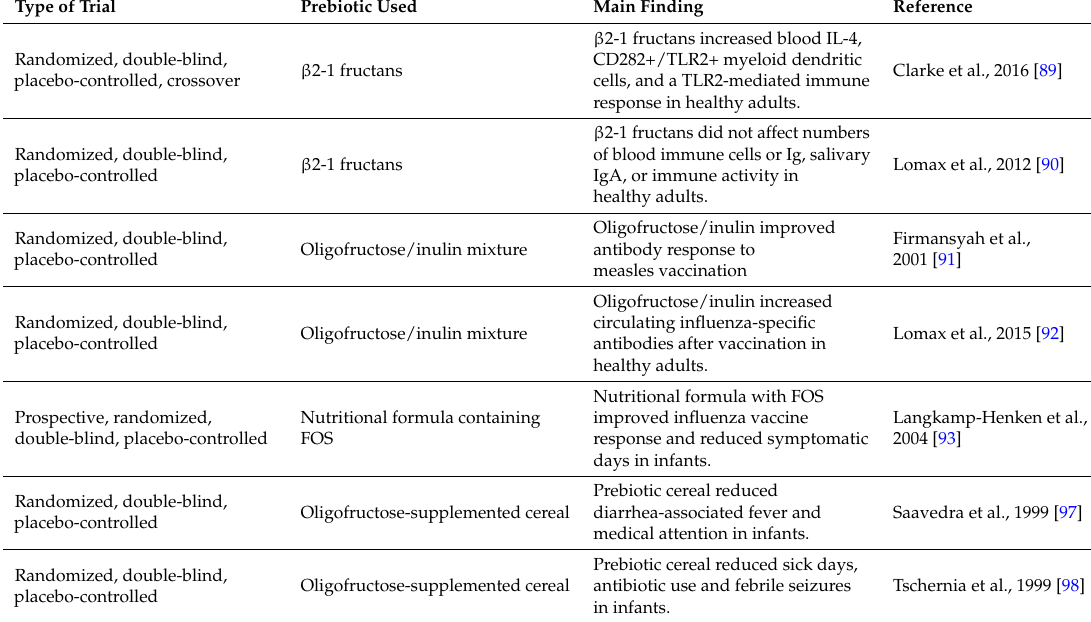
Table 3. Summary of findings from human prebiotic interventions on immune